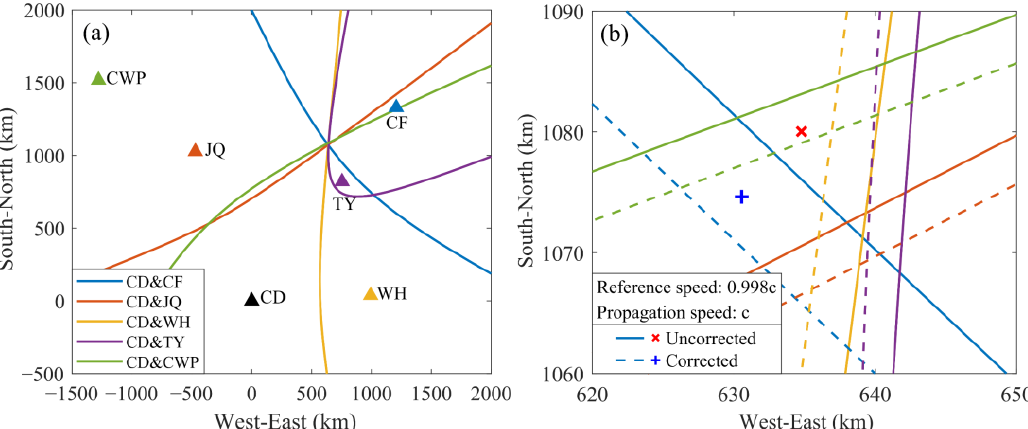
Figure 11. The horizontal projection of the hyperbolic map as well as the optimum locations for corrected (dashed lines/ “+” in blue) and uncorrected (solid line / “ × ” in red) for propagation of an unimproved case. ( a ) Five hyperbolas of different colors are shown corresponding to the following sensor pairs: CD – CF, CD – JQ, CD – WH, CD – TY and CD – CWP. Compensating the peak time delay with a reference speed of 0.998 𝑐 , and the propagation speed is 𝑐 . ( b ) The partial enlargement of ( a ) and the optimum locations.